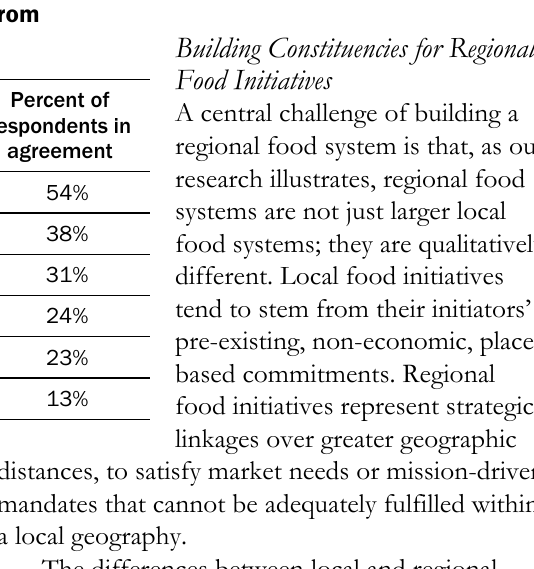
Table 1. Growing Opportunities Meeting Participants’ Levels of Agreement with Statements about the Benefits Derived from Northeastern North Carolina’s Existing Food